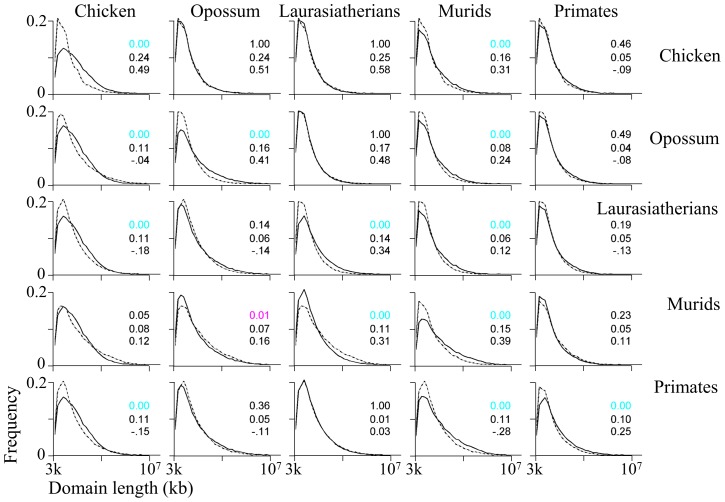
Pairwise comparisons of domain-length distributions for five taxa.Homogeneous-domain lengths are shown above the diagonal; nonhomogeneous-domain lengths are below, where the distribution curves of the species on the X-axis are solid and those on the Y-axis are dashed. On the diagonal we compare homogeneous and nonhomogeneous domain length distributions within a taxon. The first value in each plot is the p-value of significant (Kolmogorov-Smirnov goodness-of-fit test) and the colors represent the actual p-value after correcting for multiple testing using the FDR method (black>0.05 and pink<0.05). The second and third values are effect size calculated as the nonoverlapping percentage of the two distributions and Cohen's d using the Hedges' g estimator, respectively.